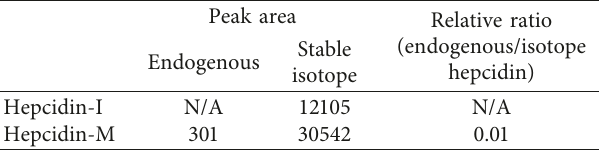
Table 3: Relative ratio of peak area between serum hepcidin-M and SI-hepcidin-I.